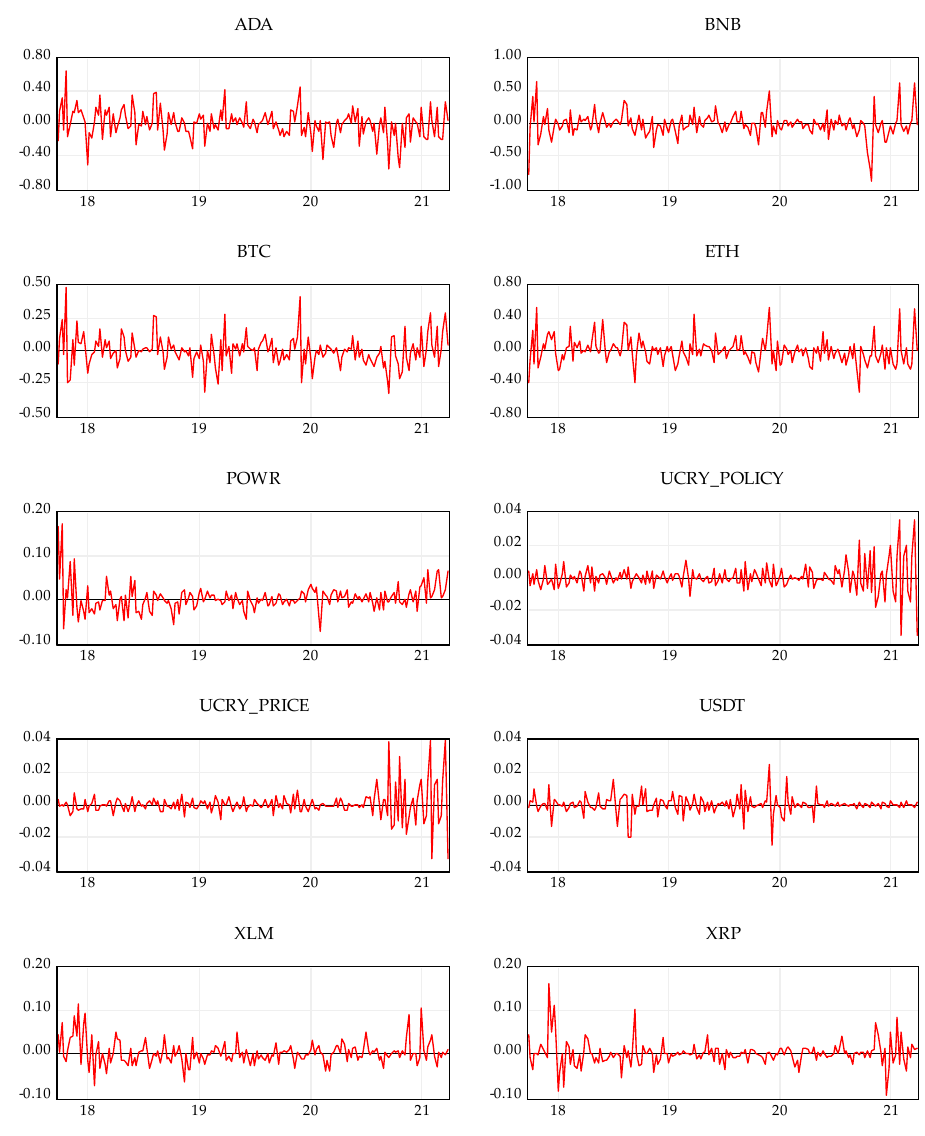
Figure 1. Plots of log returns. Table 2 presents the unconditional correlations among the cryptocurrencies and UCRY indices at zero lag. The unconditional correlation coefficients are significant at a 1% level and the correlation signs of UCRY uncertainty indices are predominantly positive with conventional cryptocurrencies and negative with sustainable cryptocurrencies, i.e.,